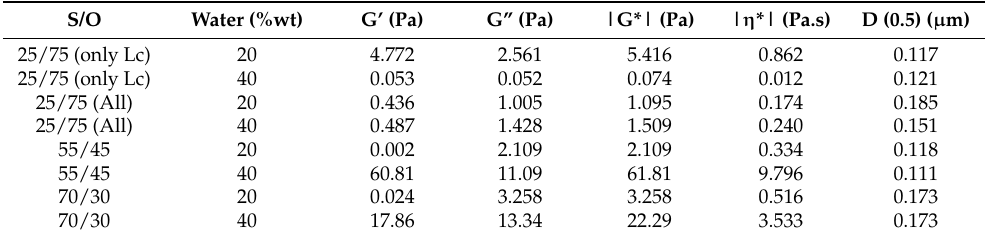
Table 3. Values of G’, G’’, |G*|, and |η*| and mean droplet size for the disperse systems measured at 0.1 Pa and 1 Hz frequency. The orange are monomodal systems and black are bimodal systems. S/O Water